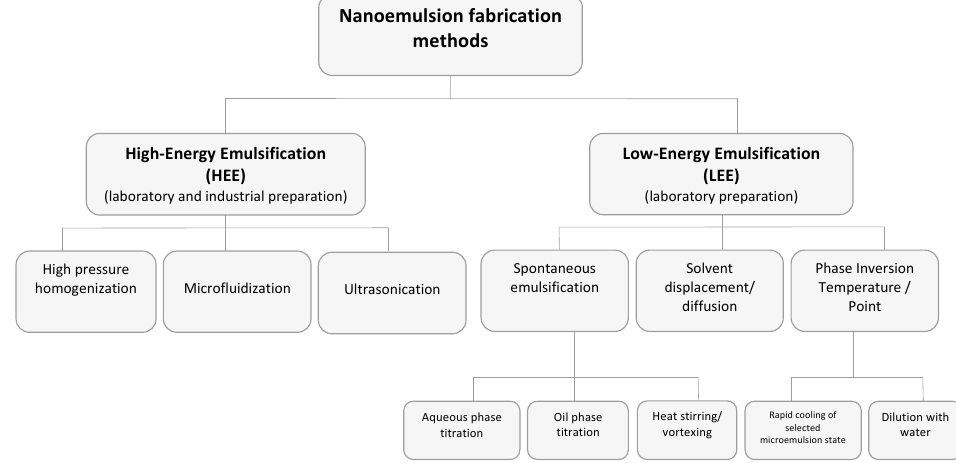
Figure 2. Schematic representation of nanoemulsion preparation methods adapted from [30,31].